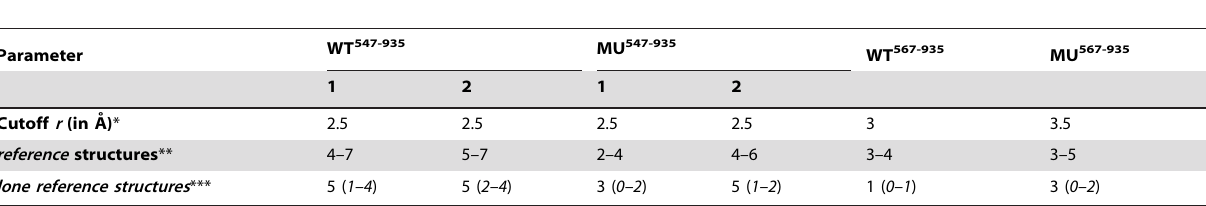
Table 1. Convergence analysis data on WT 547-935 , MU 547-935 , WT 567-935 and MU 567-935 MD trajectories.